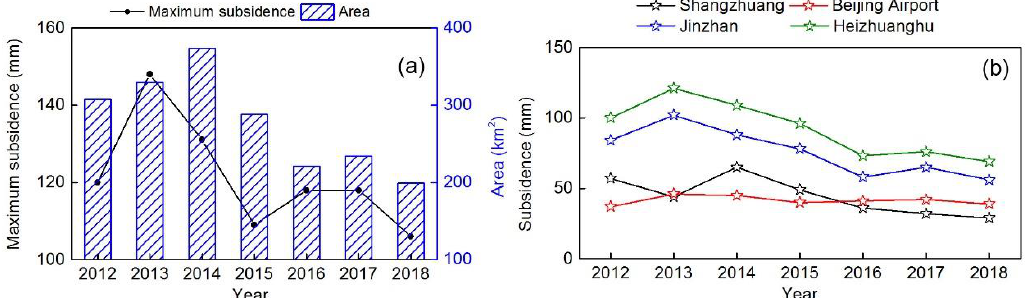
Figure 5. ( a ) The time-series subsidence changes and area of subsidence exceeding 50 mm from 2012 to 2018 in the typical Beijing region. ( b ) The annual land subsidence change from 2012 to 2018 for the four subsidence features.